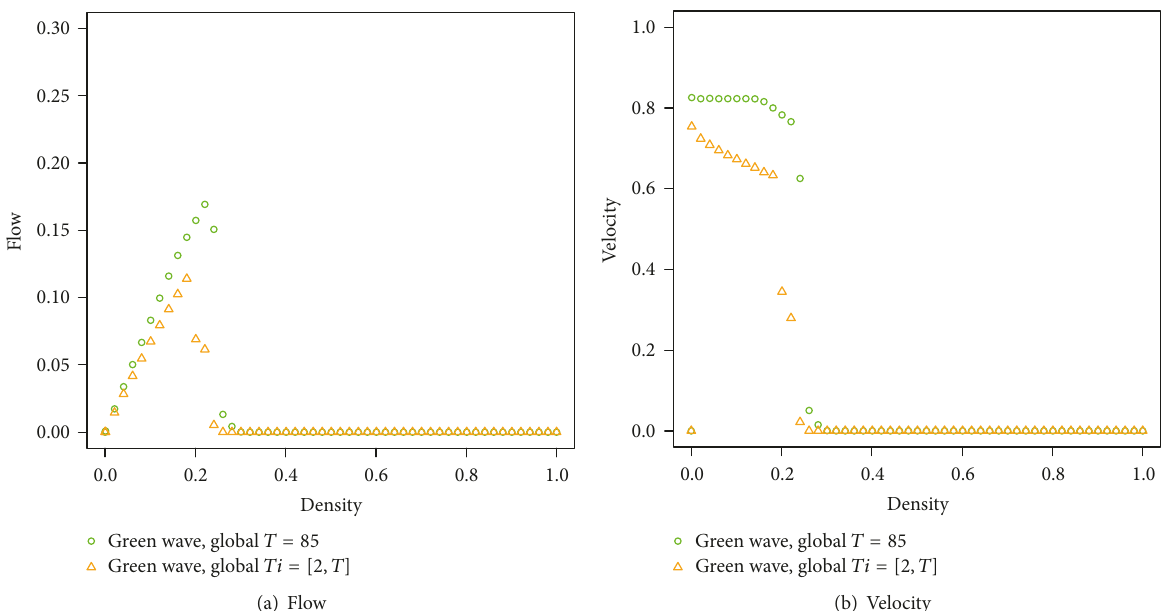
Figure 10: Flow-density and velocity-density diagrams for green wave with the same global cycle 𝑇 and a local cycle in the range of [2, 𝑇] .